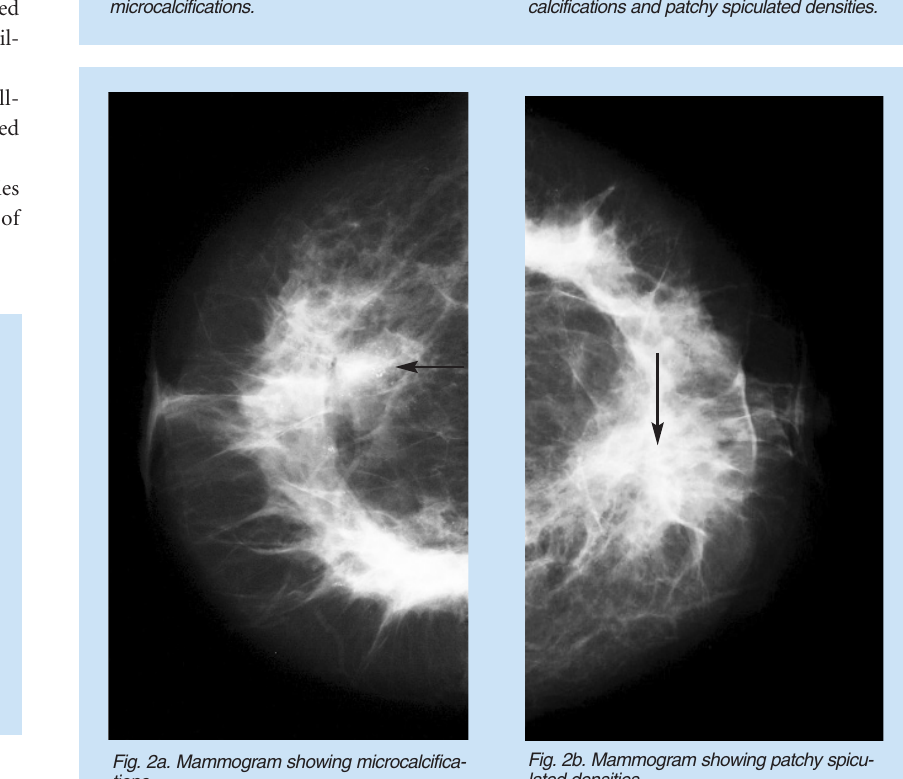
densities.Fig. 2a. Mammogram showing microcalcifica-